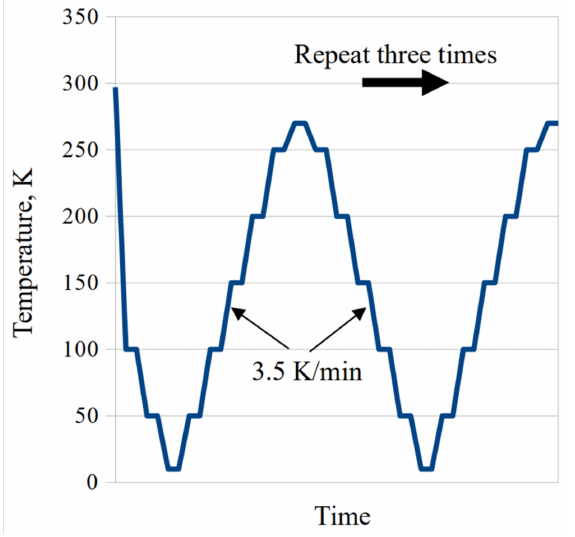
Figure 5. Schematic diagram of the temperature vs. time program for the in situ stress measurement of the W/Ti composite.